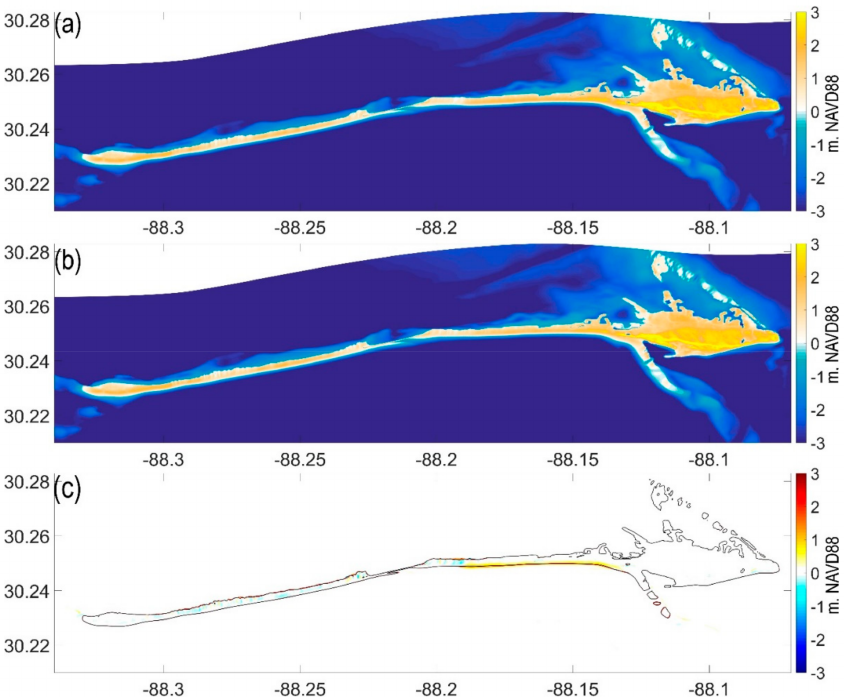
Figure 5. Post-storm 257 bed level elevations for the ( a ) nourishment scenario, ( b ) no-action scenario and ( c ) difference between nourishment and no-action scenarios. In ( c ), the black line is the 0 m contour for final (Year 30) no-action scenario and the red line is the 0 m contour for the final (Year 30) nourishment scenario.